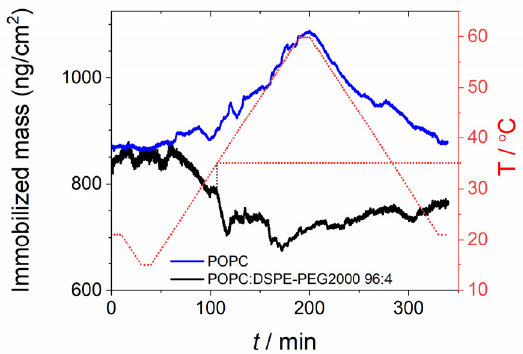
Figure 9. Effect of temperature on the mass (as determined by QCM-D) of supported lipid bilayers formed by POPC (blue line) and by POPC:DSPE-PEG2000 (96:4 moL%—black line).